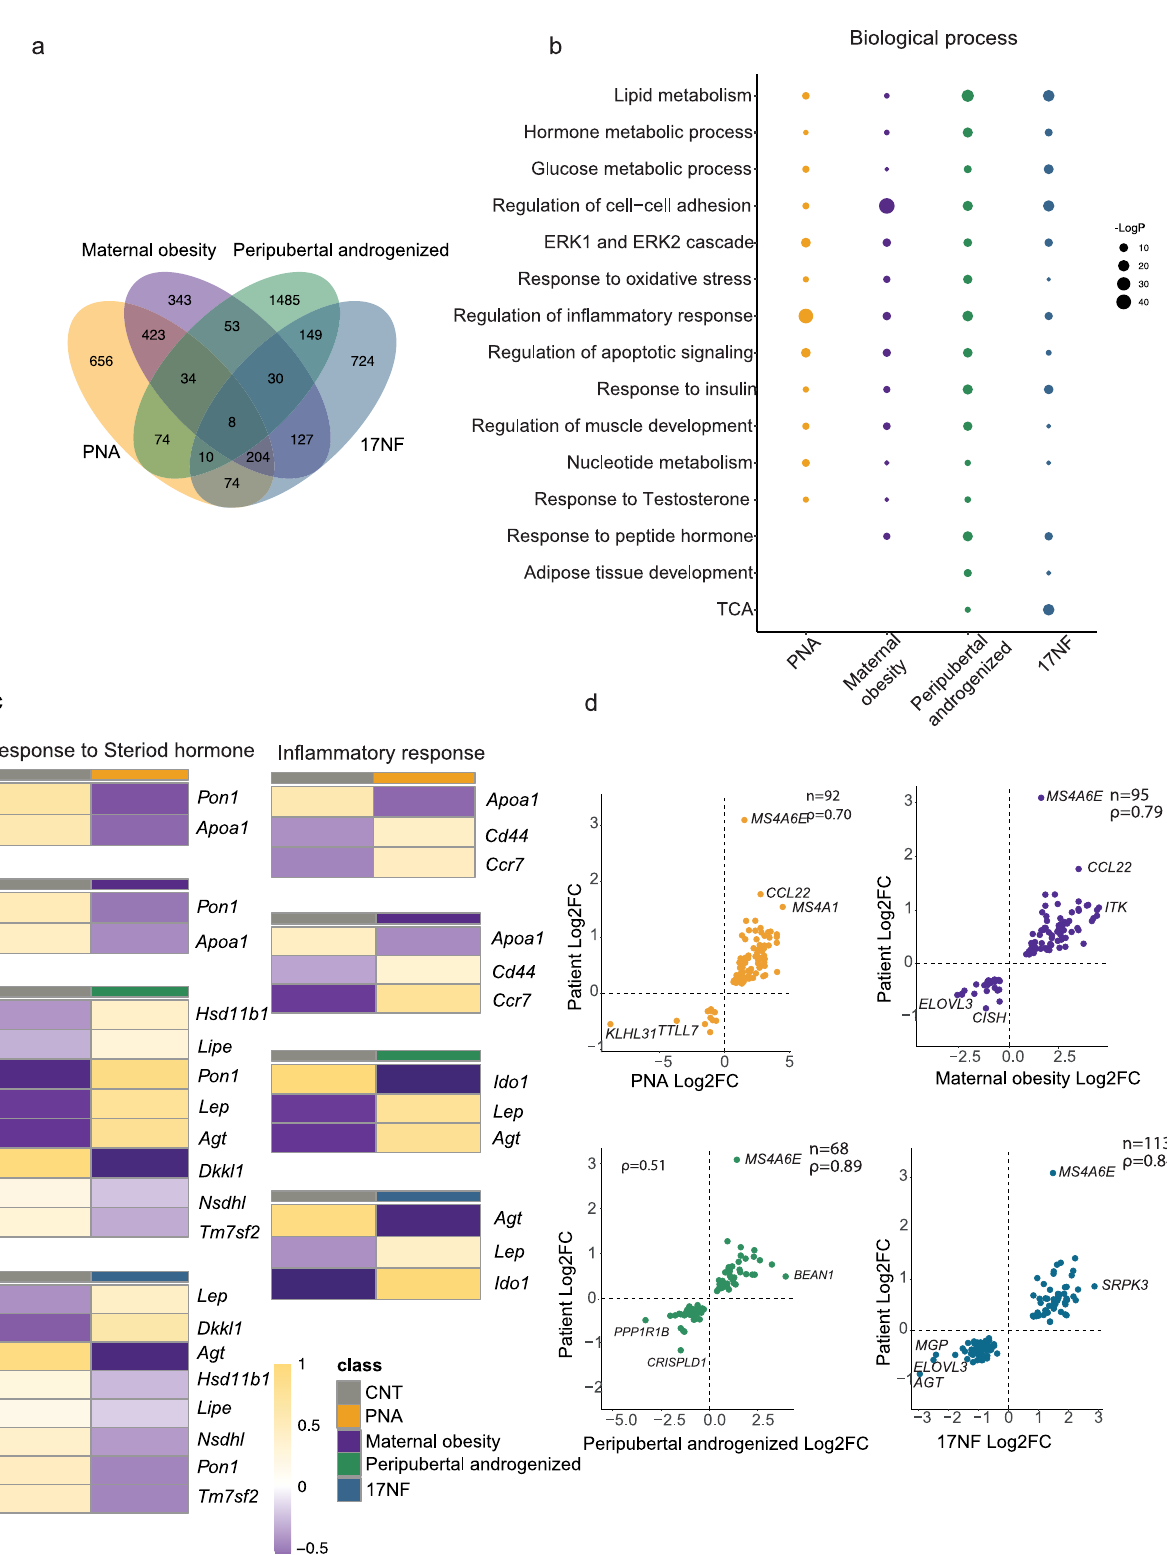
common DEGs were detected in the three PCOS-like mouse models, whereof 8 were shared by all models. Sub- sequent functional analysis of DEGs in each model shows shared biological processes; lipid, glucose, and nucleotide metabolism, regulation of in fl ammatory response, and response to testoster- one, except in 17NF model (Fig. 6b). Notably, adipose